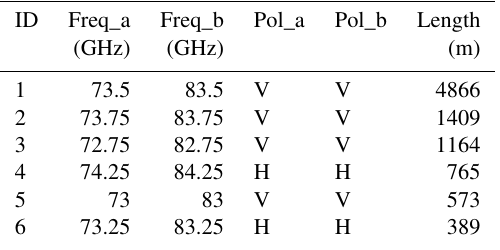
Table 2. Rainfall events used for the evaluation of CML rainfall retrieval in UTC (YYYY-mm-dd